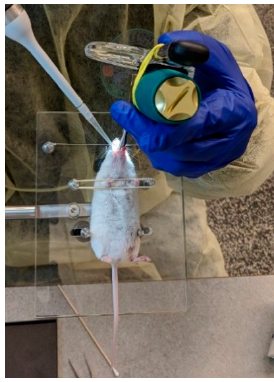
Figure 4. Administration of fluorescent microparticles by the ‘oropharyngeal aspiration’ method.